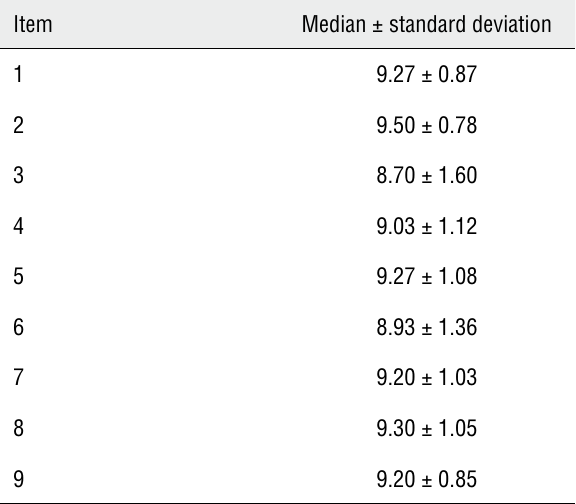
Table 1 - score of understanding and clarity of items of NIH- -CPsI (Braz) during pre-test phase.